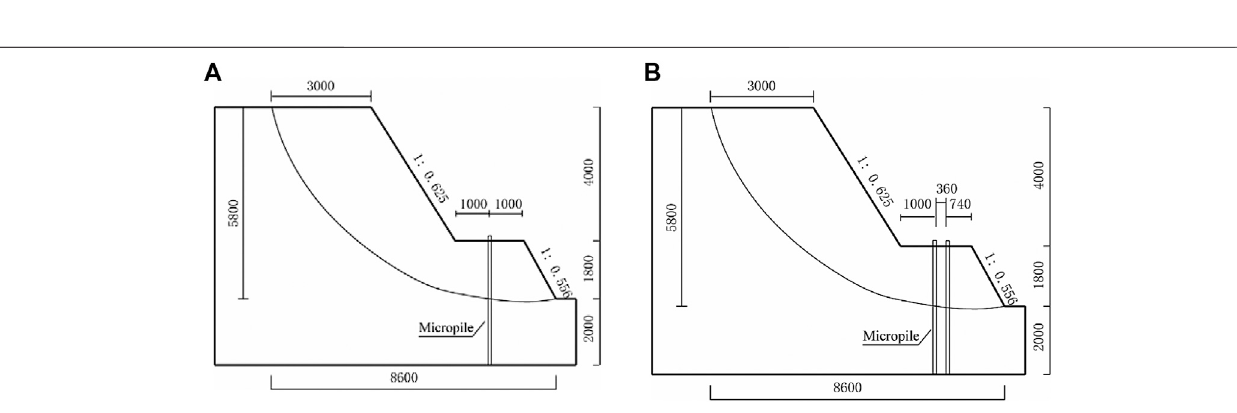
Frontiers in Earth Science |